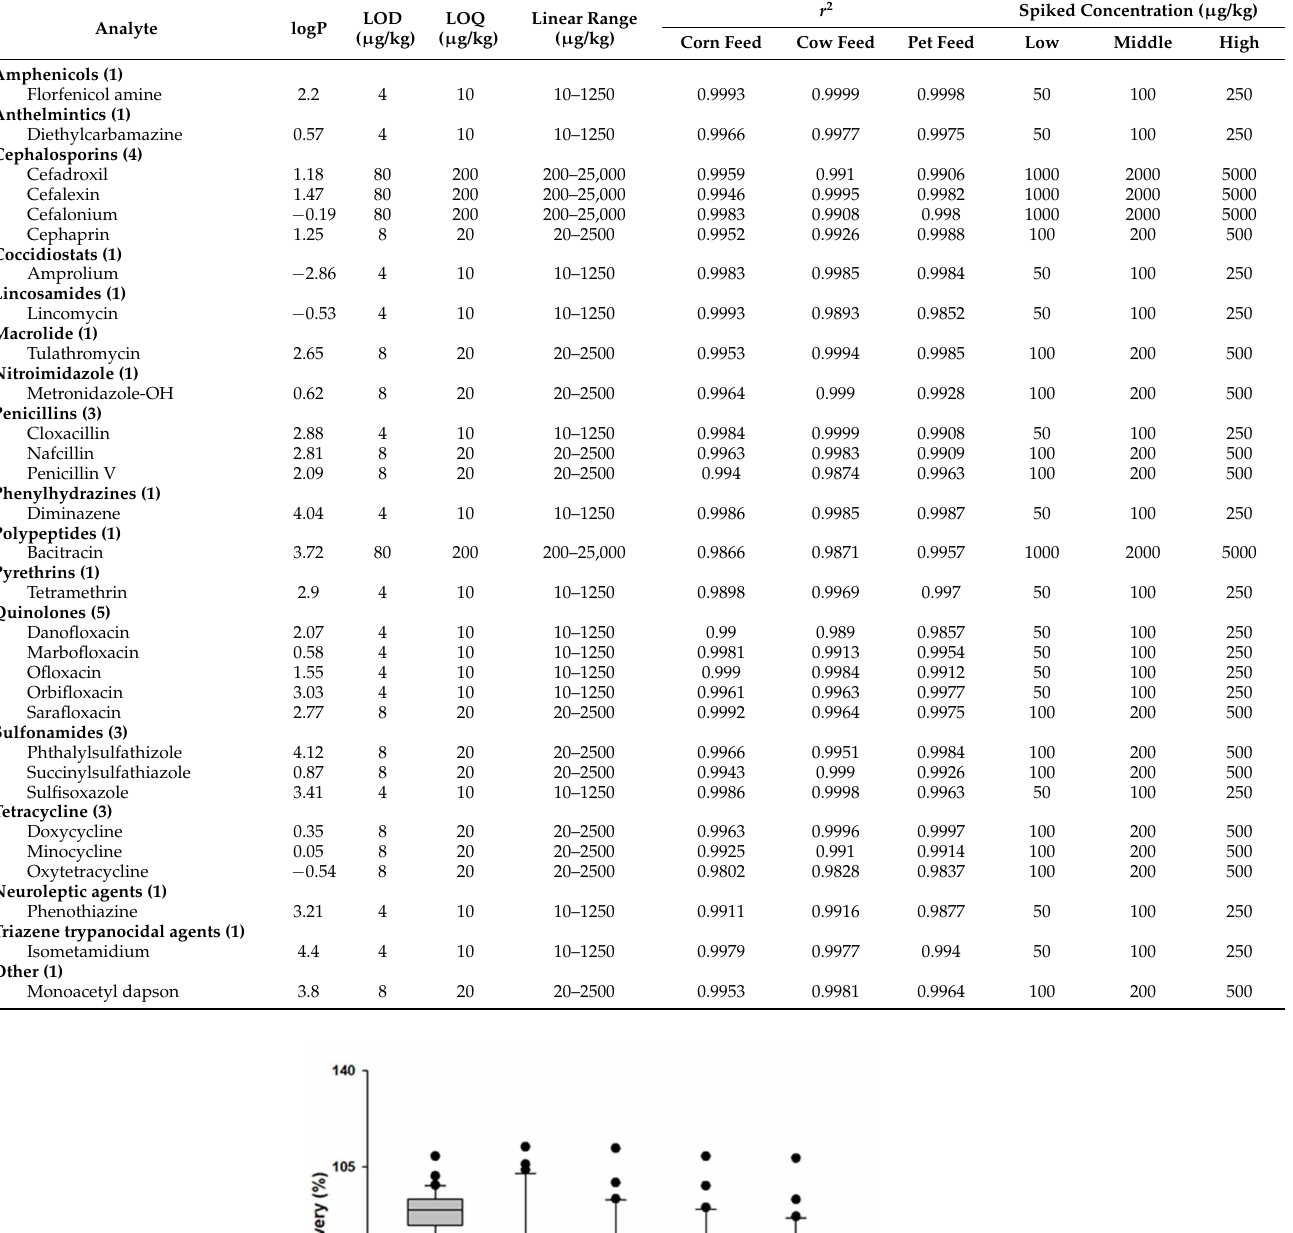
Table 1. Calibration data for optimization of the limit of detection (LOD), limit of quantification (LOQ), linear range, determination coefficient ( r 2 ), and spiked concentration for the recovery of 30 veterinary drugs in corn, cow, and pet feeds.